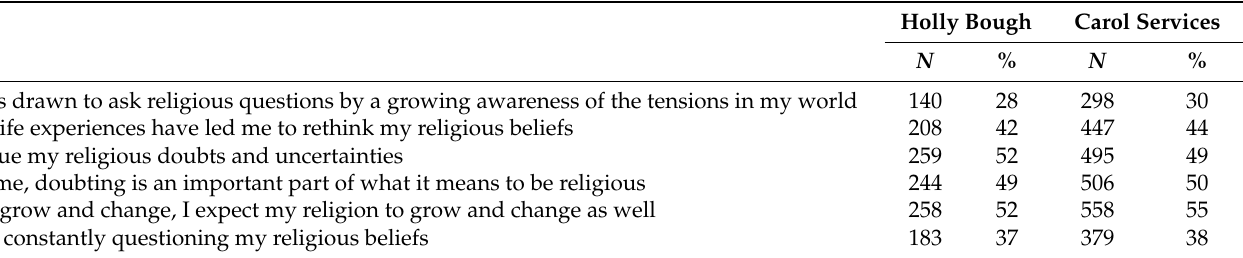
Table 14. Quest religious